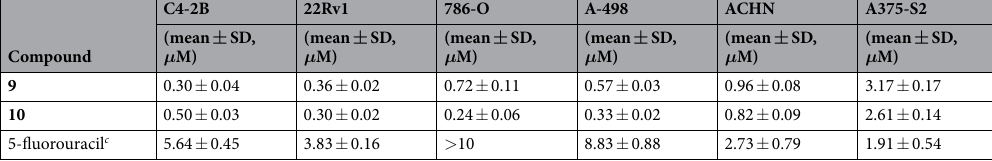
Table 3. IC 50 values a of tested compounds against human cancer cell lines. a Results were expressed as IC 50 values in μ M. b Compounds 1 – 8 and 11 – 16 were inactive for all cell lines used (IC 50 > 10 μ M). c Positive control.